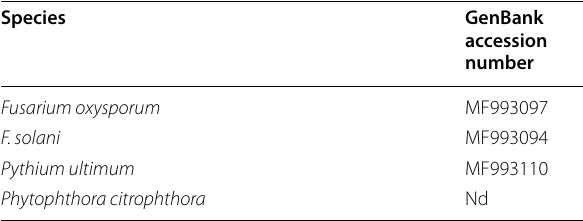
Nd not determined